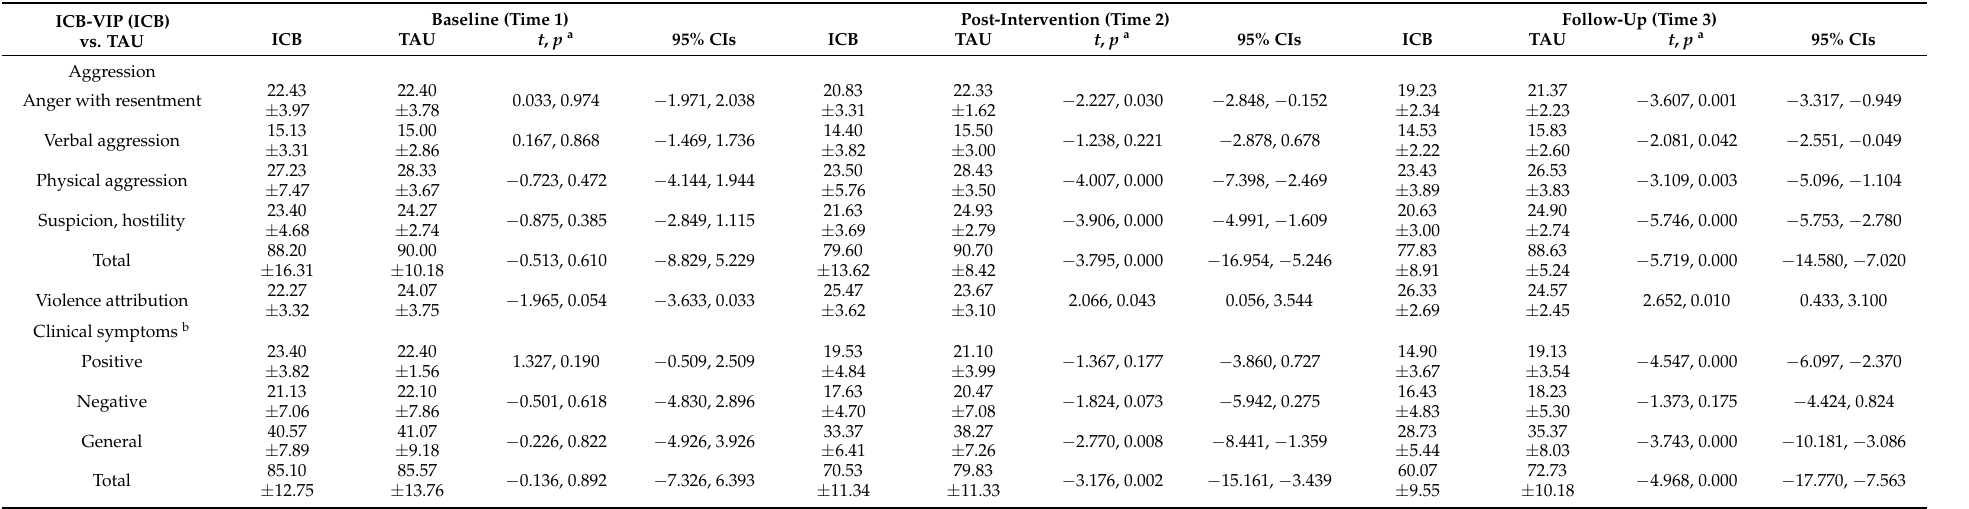
Table 2. Pre-post-intervention and follow-up data for violence and severity of clinical